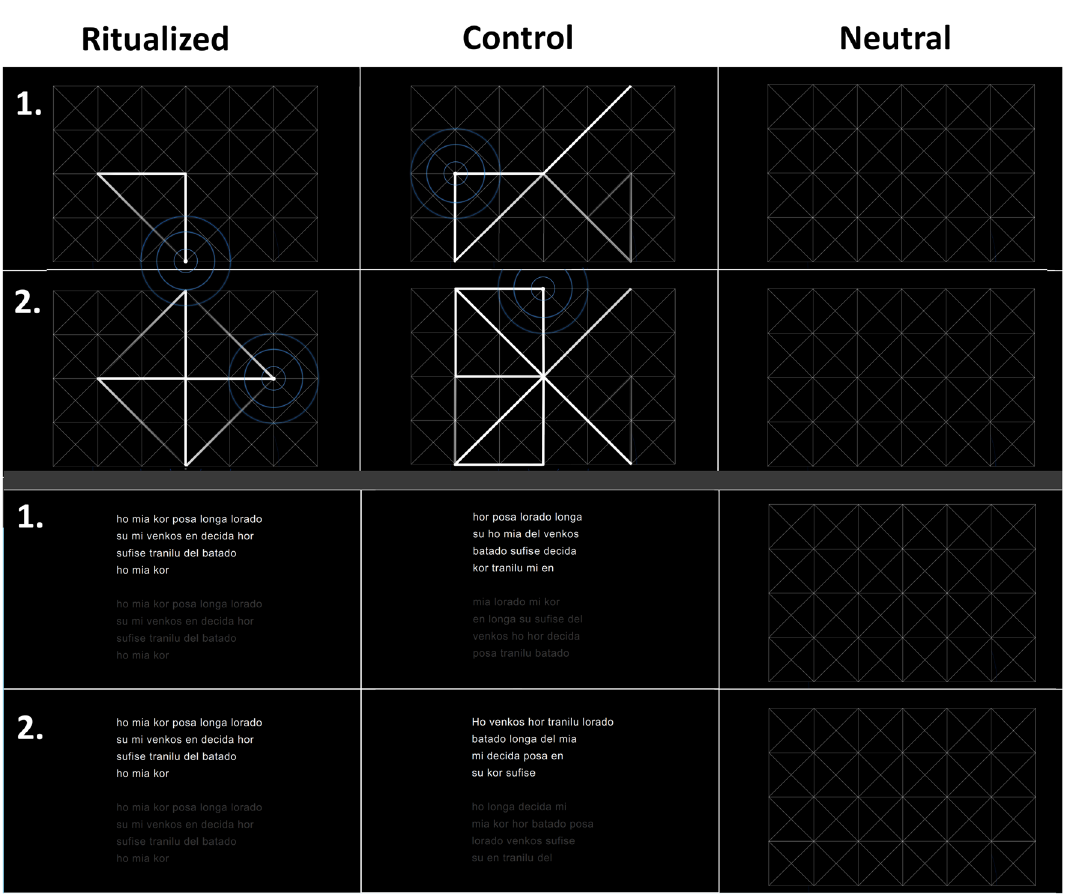
Figure 1. The motor and verbal tasks used to manipulate ritualization. Top two rows: motor task. In the ritualized condition, the dot moved predictably in rigid patterns, while in the control condition, the dot’s movements were unpredictable, as illustrated by the trace line (which was not visible to participants). Steps 1 and 2 were sampled from the movement sequence to illustrate the dynamics of the moving dot. In the neutral condition, participants only watched the white grids without the moving dot. Bottom two rows: verbal task. In the ritualized condition, participants read aloud the same stanza for three minutes in the ritualized condition, while in the control condition, they read randomly ordered words from the same stanza. The second verse is grayed out so that participants know it will come (as in karaoke). In the neutral condition, participants again watched the same white grid as in the motor